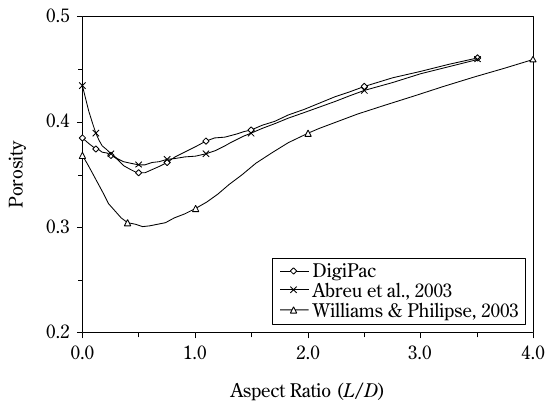
Porosity versus aspect ratio for the packing of spherocylin-